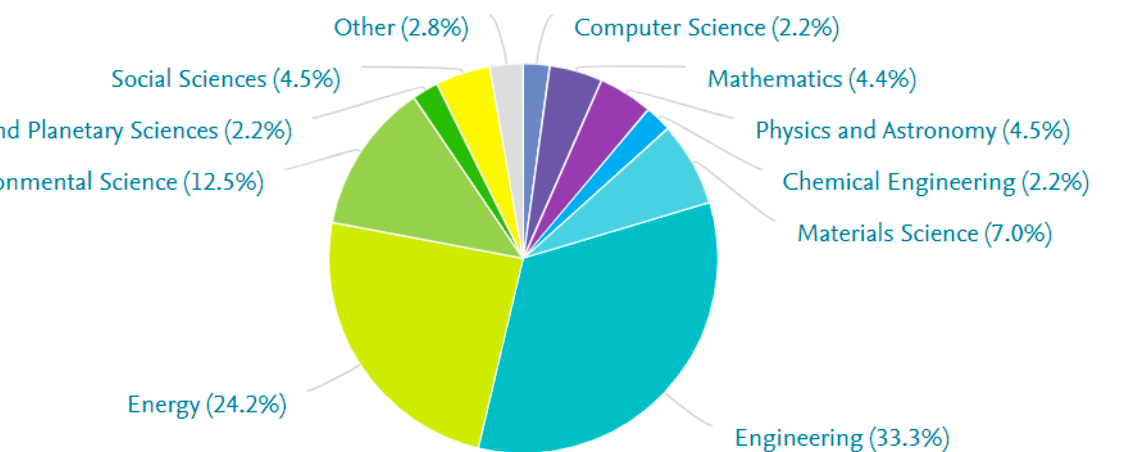
Figure 24. Publications by subject area (accessed on 21 January 2022).